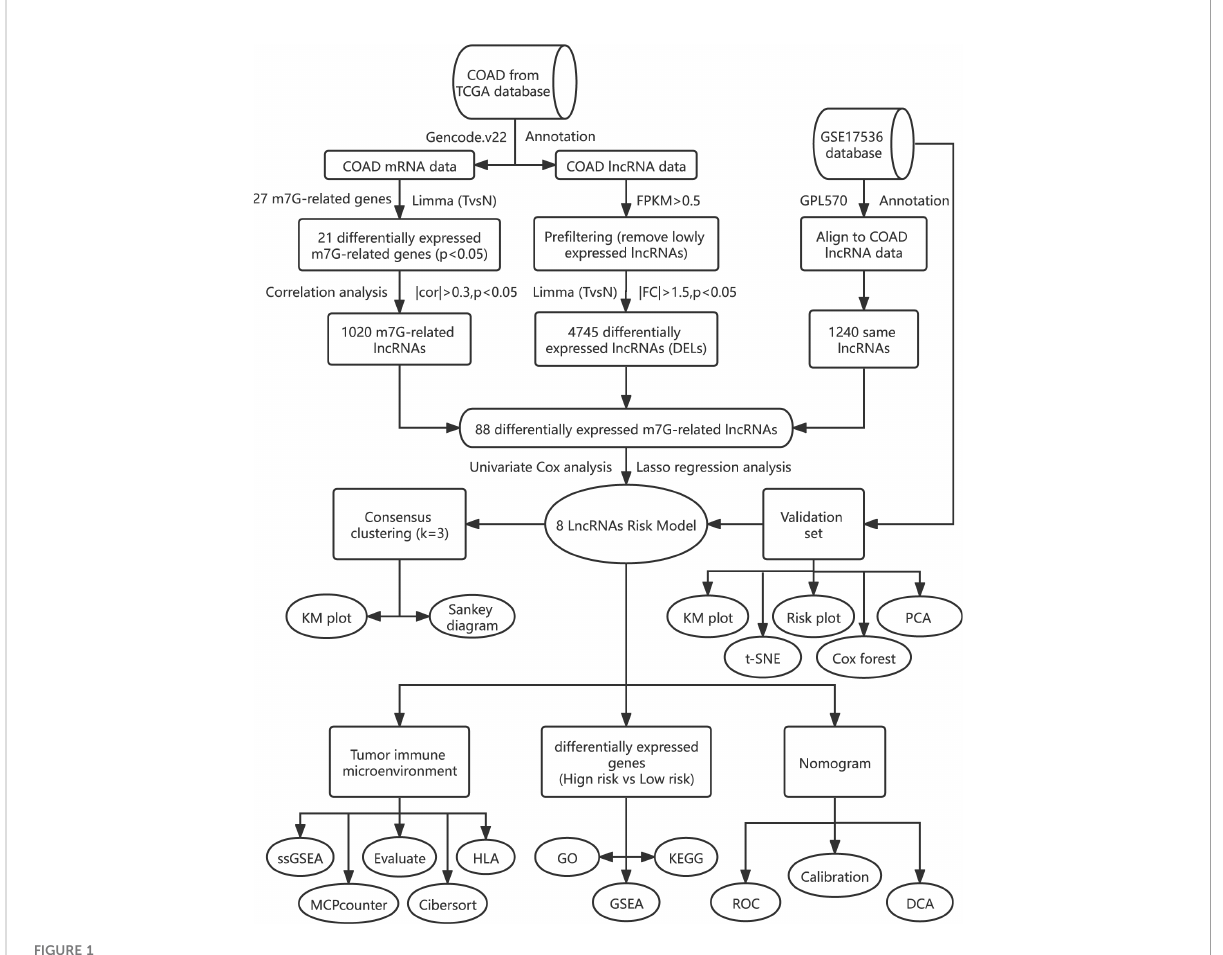
FIGURE 1 The fl owchart of the overall study